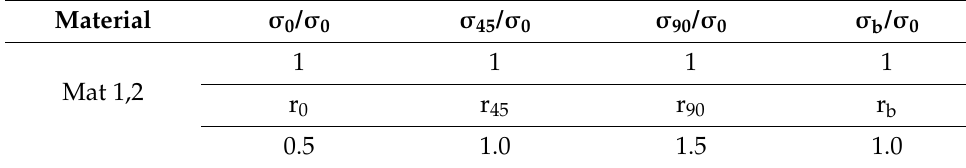
Table 1. Anisotropic mechanical properties. The subscripts 0, 45, 90 represent rolling direction (RD), diagonal direction (DD), and transverse direction (TD), respectively.